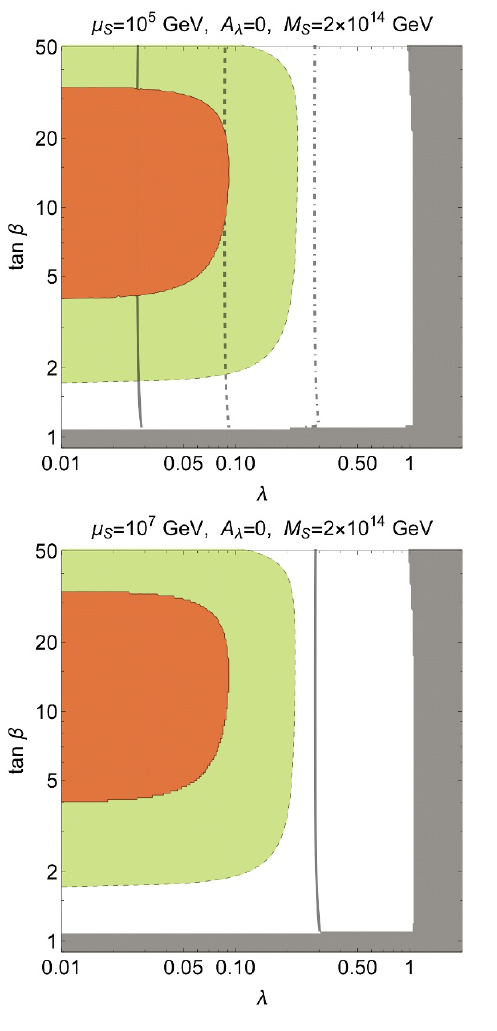
Figure 2 . The regions corresponding to absolute stability (unshaded), metastability (green) and instability (orange) of the electroweak vacuum in tan (cid:12) - (cid:21) plane for di(cid:11)erent values of (cid:22) S and A (cid:21) , and for (cid:22) = 1 TeV, M t = 173 : 1 GeV and M S = 2 (cid:2) 10 14 GeV. The region shaded in grey is disfavoured by the non-perturbativity of at least one or more couplings. The vertical black contour lines correspond to (cid:1) m 0 = 200 keV (solid), 2 MeV (dashed) and 20 MeV